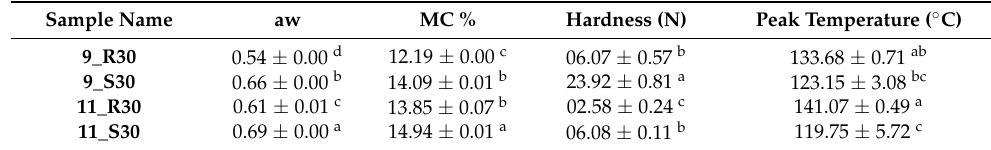
Table 2. Water activity (a_w), moisture content (MC %), hardness (N) and peak temperatures (°C) for different formulations.